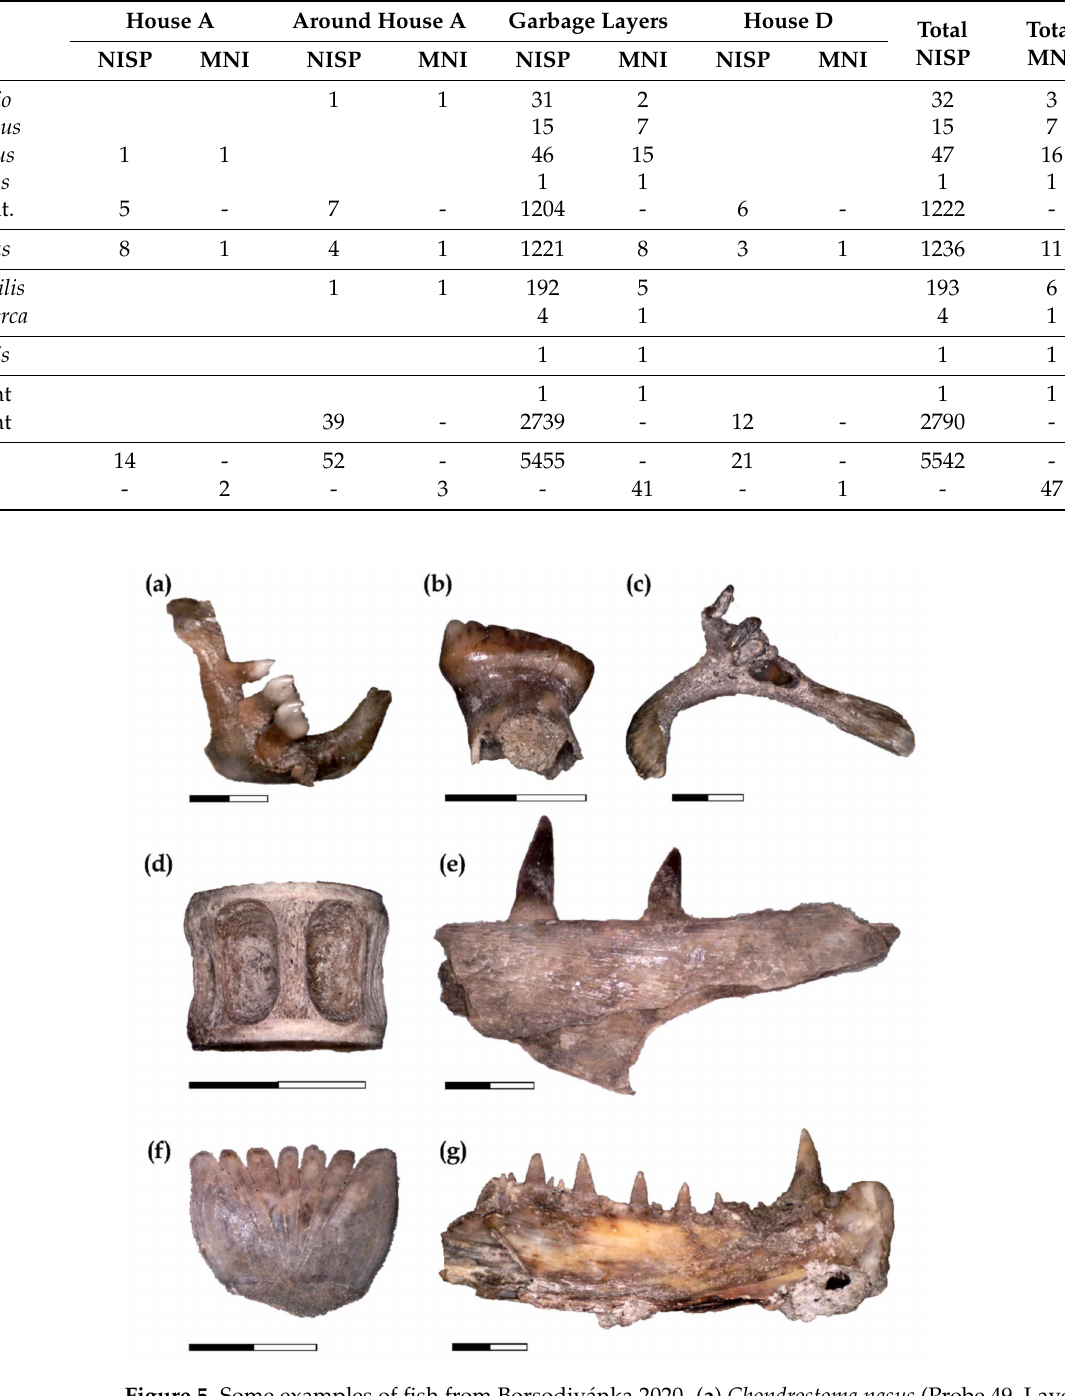
Figure 5. Some examples of fish from Borsodiv á nka 2020. ( a ) Chondrostoma nasus (Probe 49, Layer 7), left pharyngeal arch. ( b ) Cyprinus carpio (Probe 44, Layer 7), left 2nd pharyngeal tooth. ( c ) Rutilus rutilus (Probe 40, Layer 7), left pharyngeal arch. ( d ) Esox lucius (Probe 48, Layer 7), precaudal vertebra. ( e ) Esox lucius (Probe 48, Layer 7), a fragment of the left dentary. ( f ) Perca fluviatilis (Probe 44, Layer 7), scale. ( g ) Sander lucioperca (Probe 49, Layer 7), left dentary incomplete. Scale 5